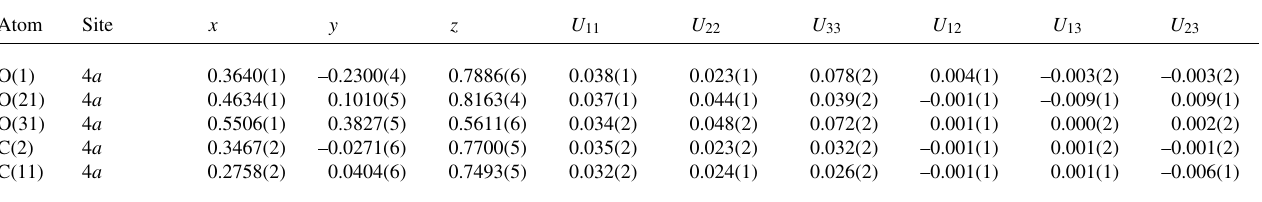
Table 3. Atomic coordinates and displacement parameters (in Å 2 )